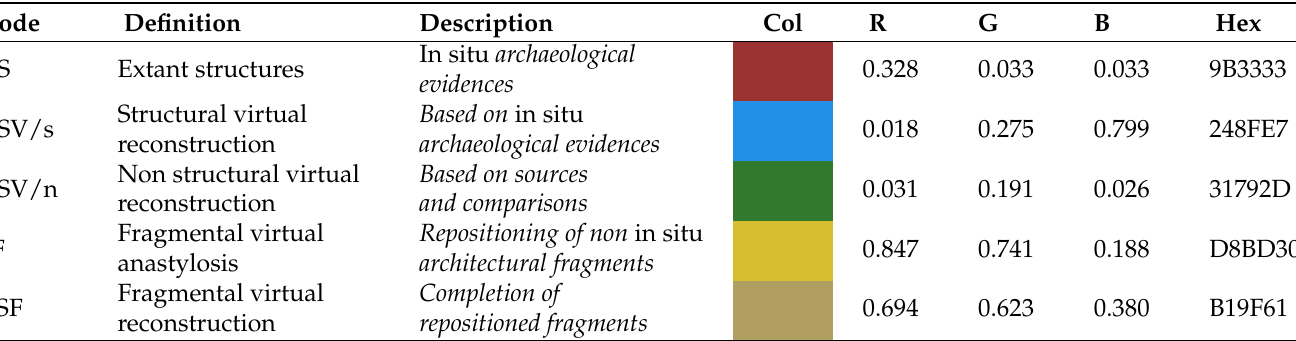
Table 3. EM nodes and color schema (RGB ed Hex